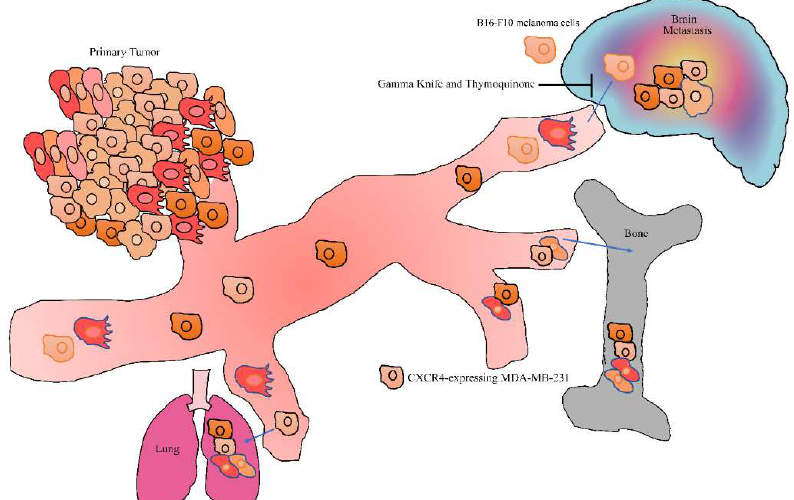
Figure 2. Metastatic spread of cancer cells to distant organs.